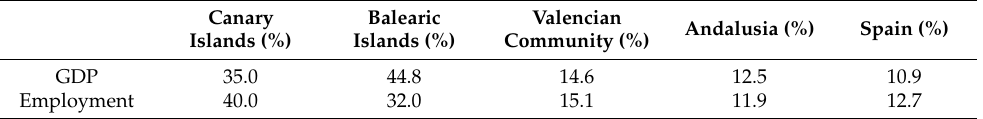
Table 1. Comparison of tourism activity and impacts for some regional economies